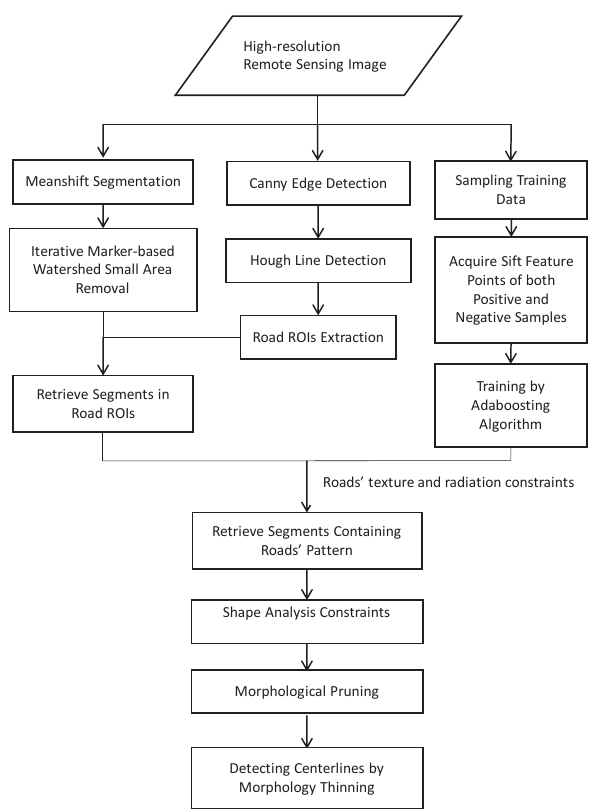
Figure 1. Road Extraction MainFrame